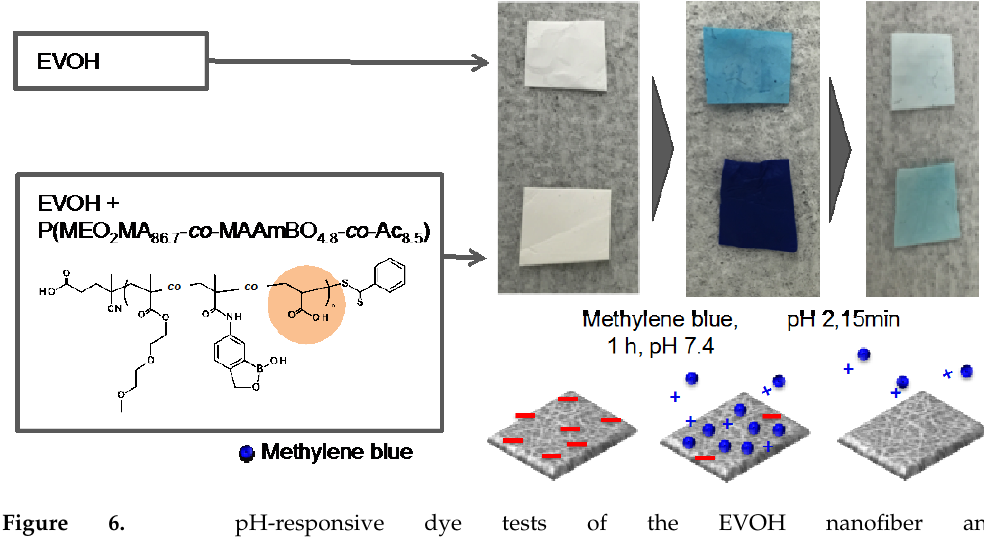
Figure 6. pH-responsive dye tests of the EVOH nanofiber and EVOH/P(MEO 2 MA 86.7 - co -MAAmBO 4.8 - pH-responsive dye tests of the EVOH nanofiber and co -Ac 8.5 ) nanofiber using methylene blue solution. Blue and red colors in the illustration are cationic EVOH/P(MEO 2 MA 86.7 - co -MAAmBO 4.8 - co -Ac 8.5 ) nanofiber using methylene blue solution. methylene blue and anionic Ac units, respectively. Blue and red colors in the illustration are cationic methylene blue and anionic Ac units,